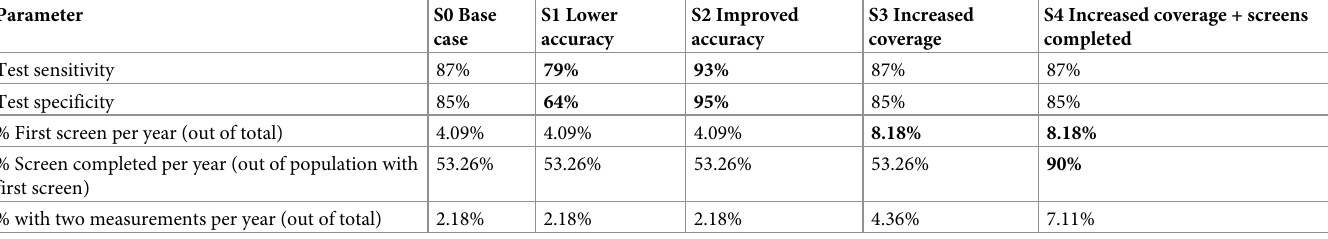
Table 3. Summary of different simulation scenarios considered.